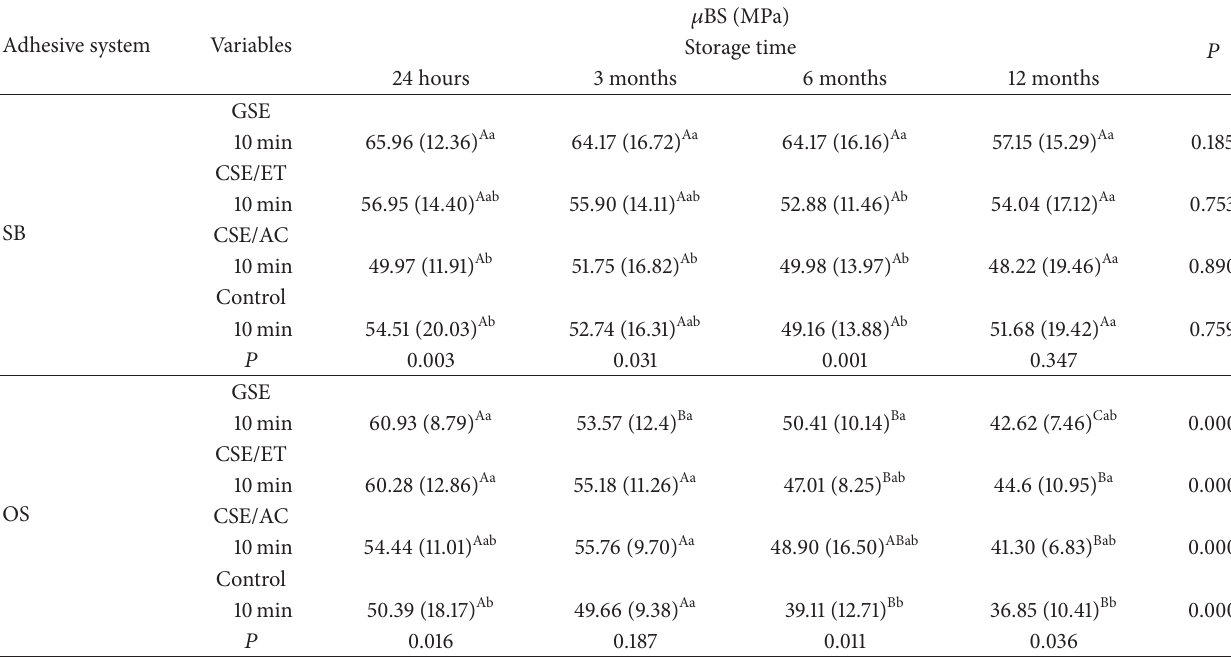
Table 2: Bond strength (MPa) of demineralized dentin treated (standard deviation) with different dentin biomodification agents in different application times and storage periods for Single Bond Plus (SB) and One Step Plus (OS). One-way ANOVA 𝑃 values for different statistical groups.